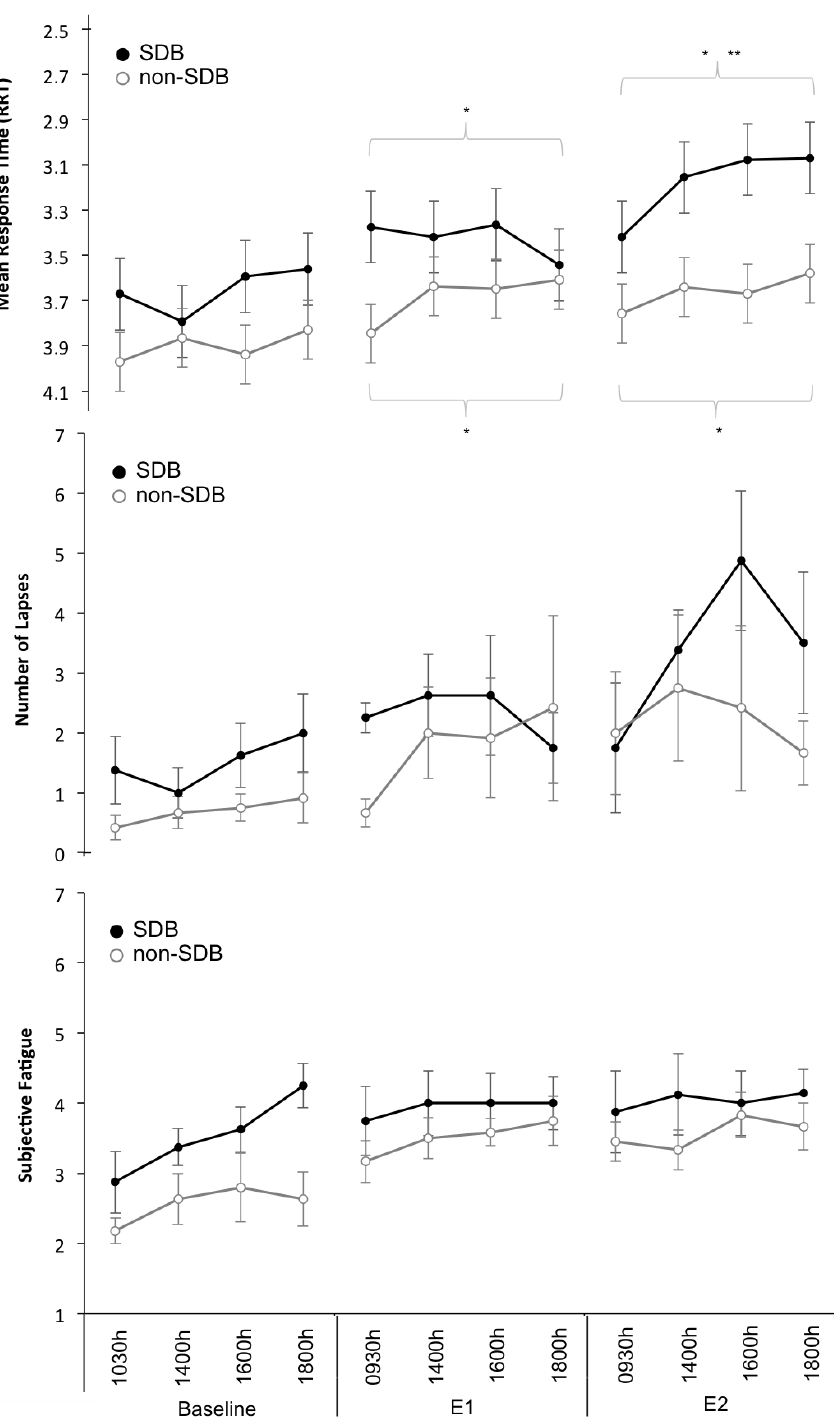
Figure 2. Wake Variables. Mean ˘ Standard error or measurement (SEM) for (top panel to bottom panel): Response time (reciprocal transformation used, RRT and scale inverted). Lapses (Response Times >500 ms) and Subjective Fatigue Ratings across the 3-days: Baseline, Experimental Day 1 (E1), Experimental Day 2 (E2) and across Time: 0930/1030, 1400, 1600, 1800. * Denotes significant difference compared to Baseline Day; ** Denotes significant difference compared to Experimental Day